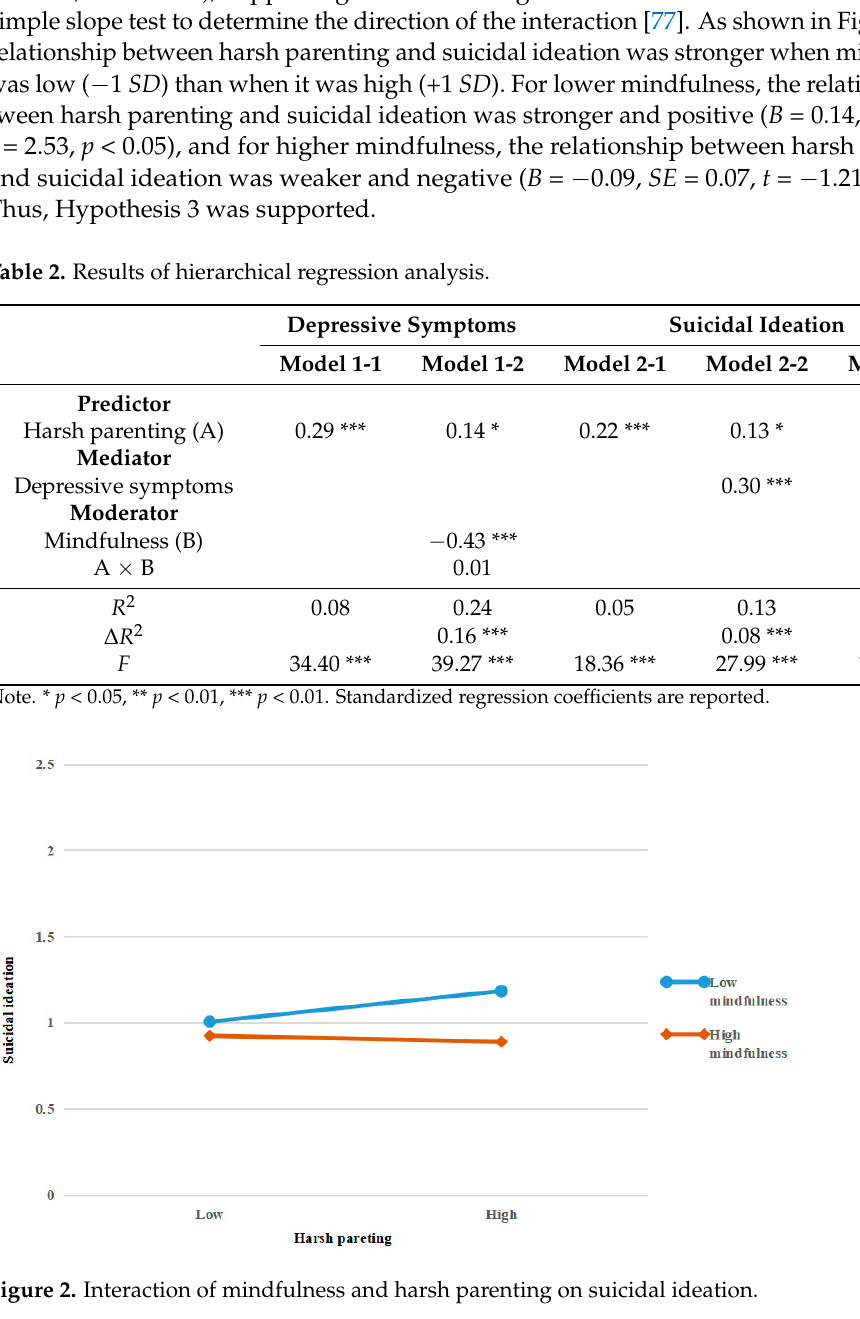
Table 3. Conditional indirect effects of harsh parenting on suicidal ideation through depressive symptoms.